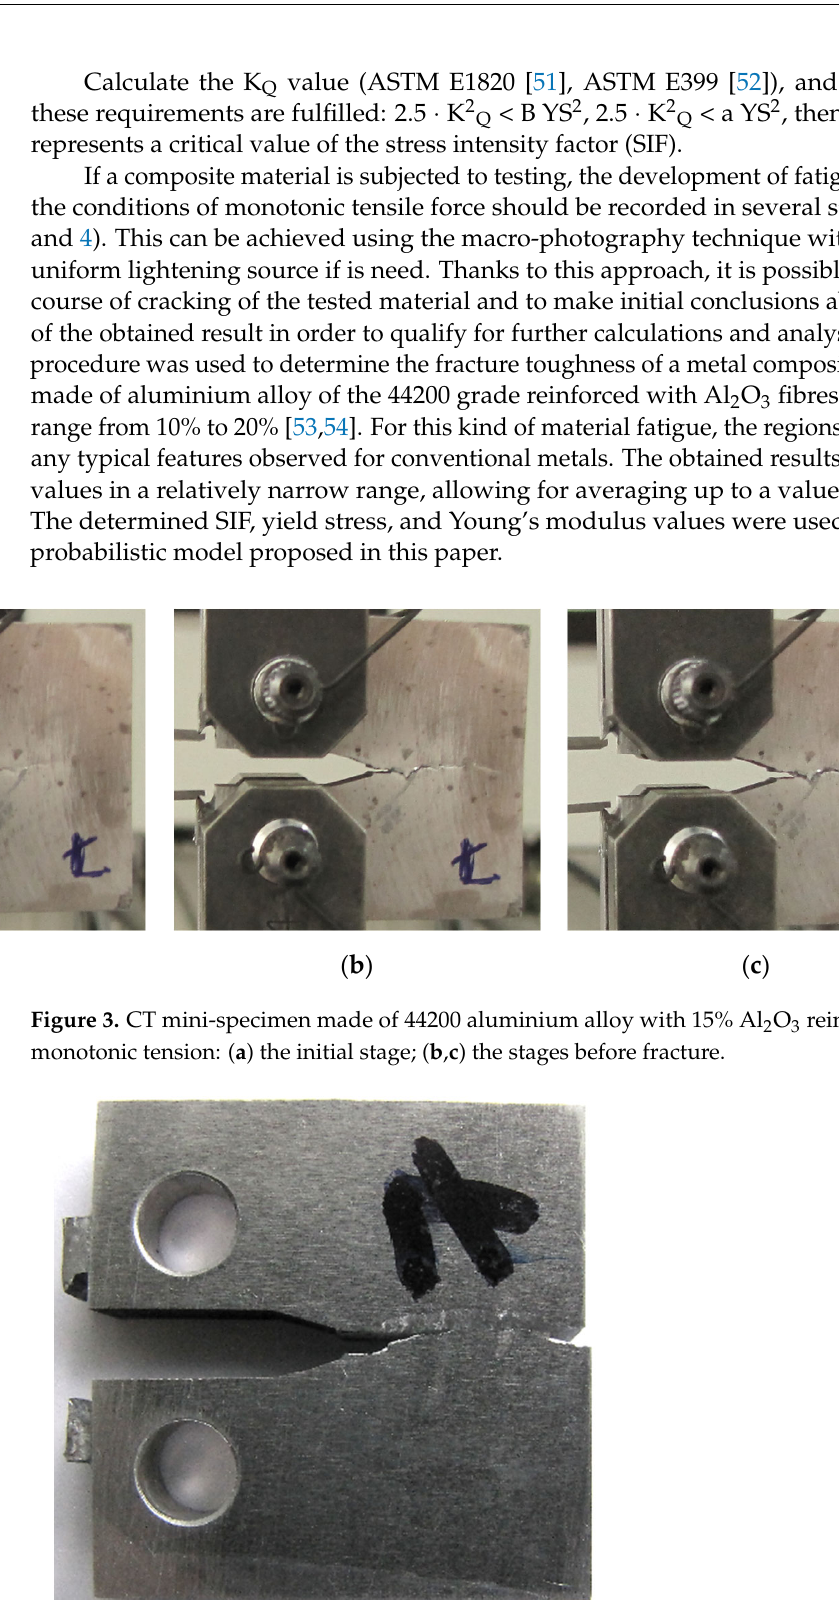
Figure 4. CT mini ‐ specimen made of 44200 aluminium alloy with 15% Al 2 O 3 reinforcement (Sa ffi l fi bres) after the fracture toughness test.